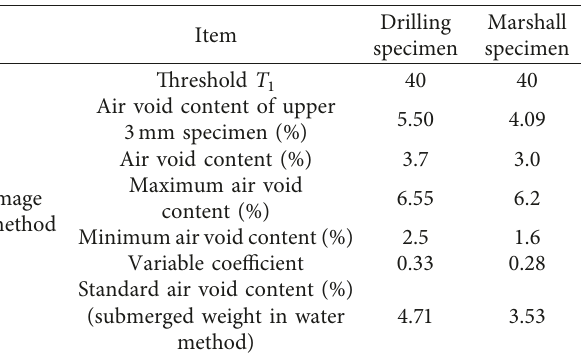
Table 3: Statistical table of air void